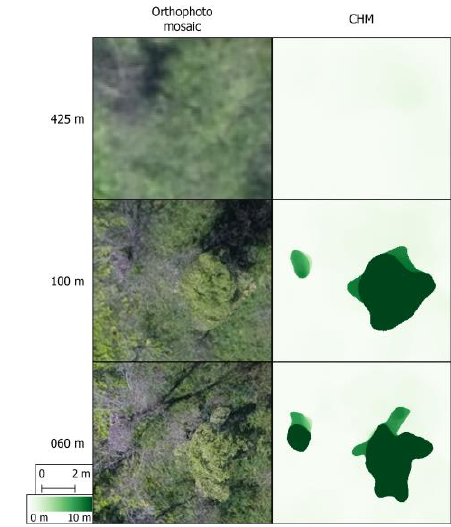
Figure 5. Details of the orthophoto mosaics and canopy height models computed from the UAV-based imagery acquired at different flight heights in a burned and in a regenerated tree.